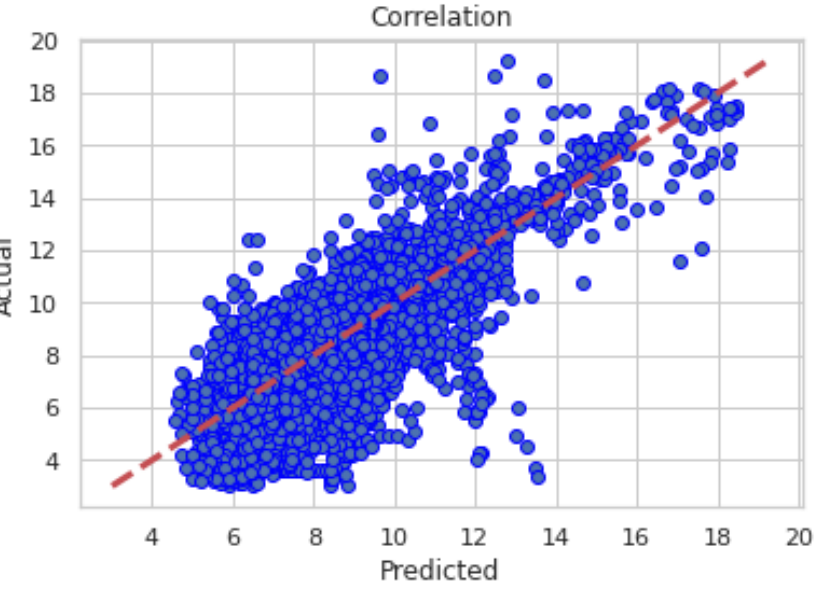
Figure 4. Correlation between observed (measured) data and results from the RF trained only with mesoscale data in ms − 1 .